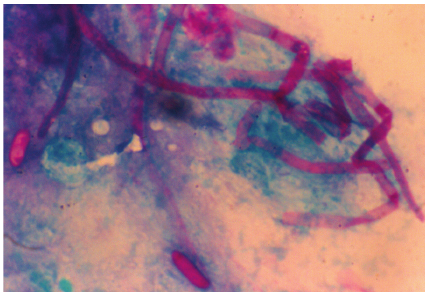
Figure 8: PAS stain in smear from keratitis caused by melanized fungus × 400.